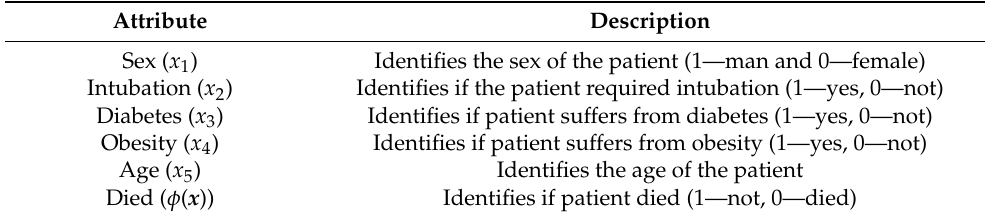
Table 6. Attributes in the experimental